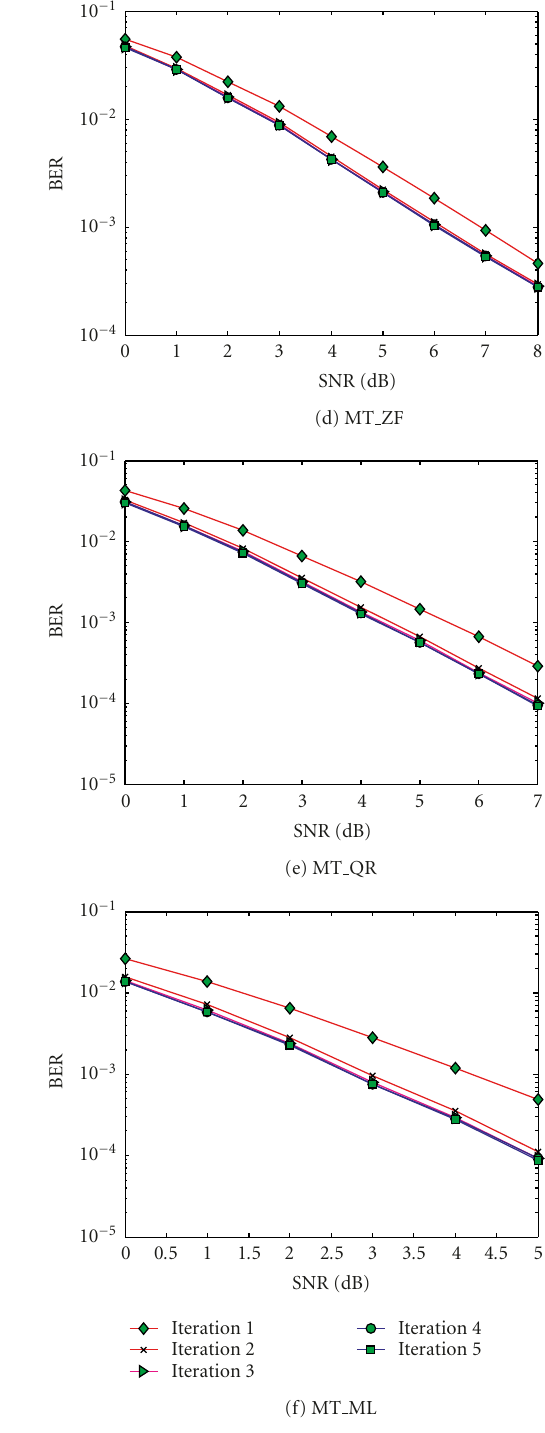
performance of the direct transmission is the same as shown in Figure 7 due to the unchanged source-destination channel qualities. With the improved relay-destination channel, the relay forwards the processed information of the sources more reliably, thus enhancing the spatial diversity at the